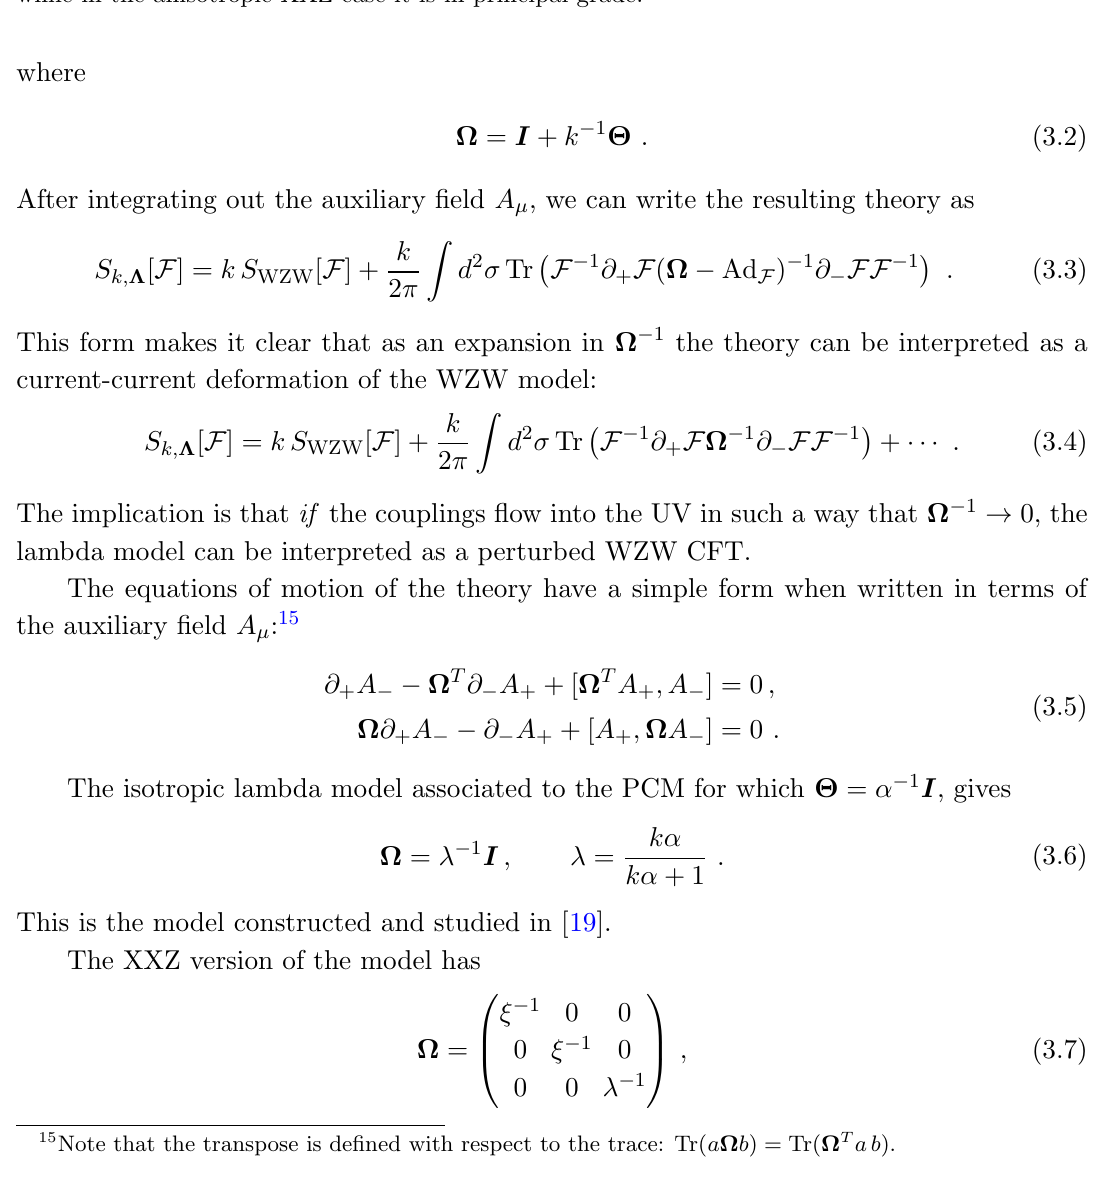
Table 1 . The symmetries of the sigma models. The deformation parameter of the quantum group is given in (2.20) in terms of the underlying coupling constants. The only (subtle) di(cid:11)erence between the symmetries is that in the YB case, the a(cid:14)ne quantum group is naturally in homogeneous grade, while in the anisotropic XXZ case it is in principal